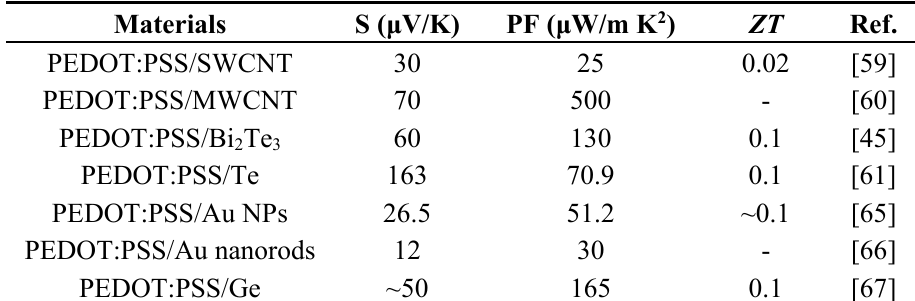
Table 2. TE properties of PEDOT-based hybrid